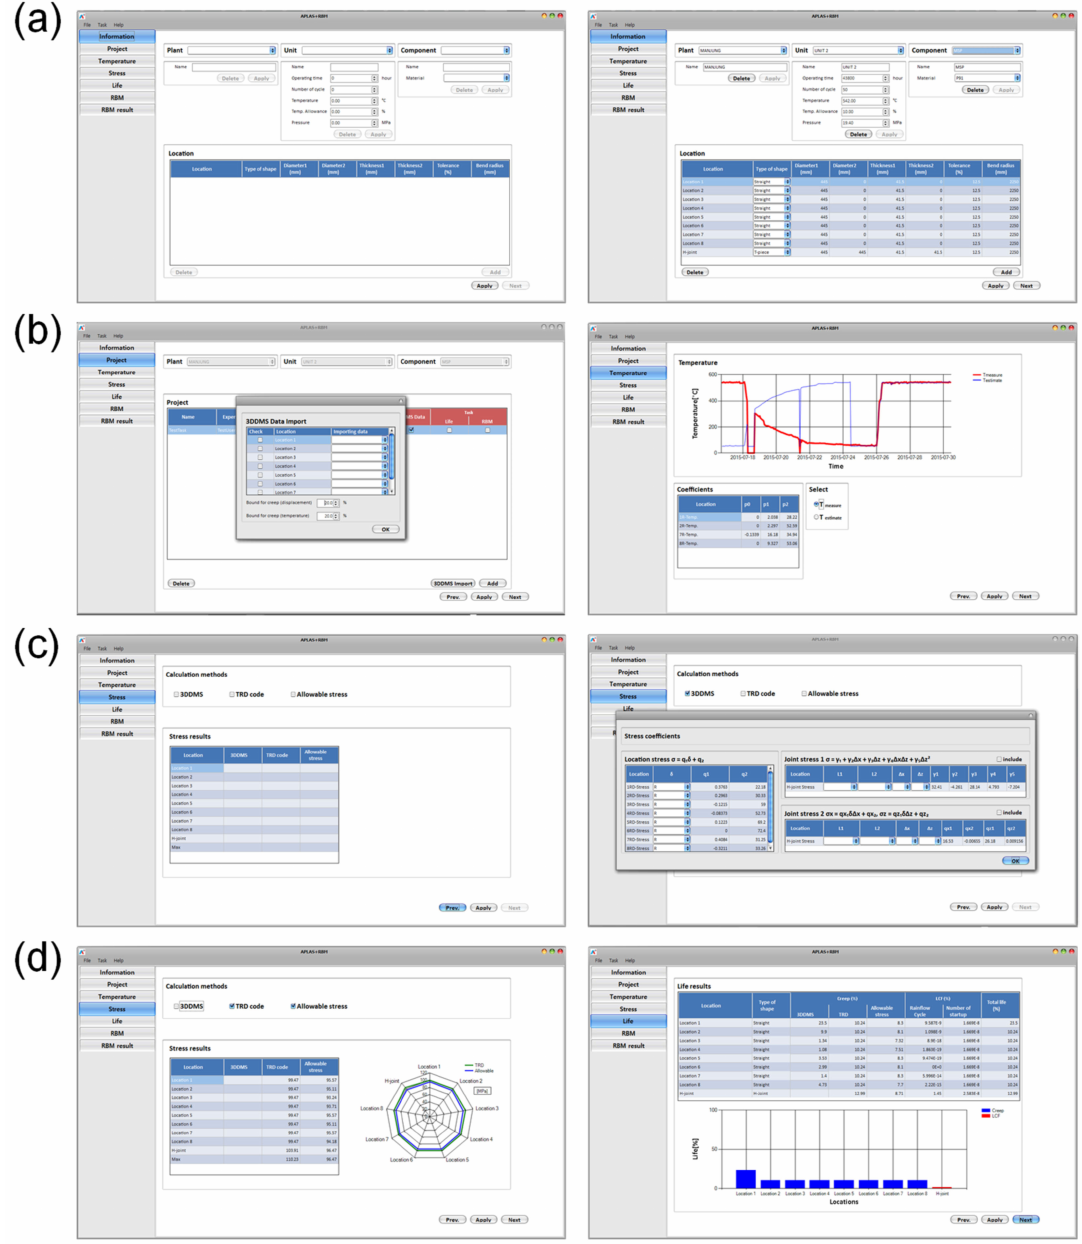
Figure 5. Display of life-assessment software for piping systems: ( a ) basic information, ( b ) 3DDMS importing and temperature calculation, ( c ) stress calculation, and ( d ) life